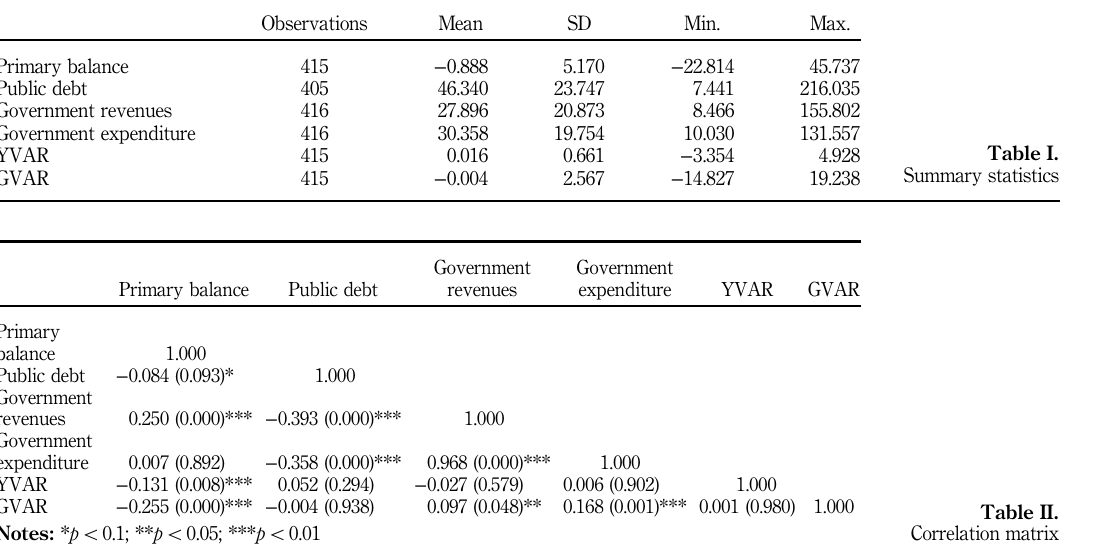
Table II. Correlation